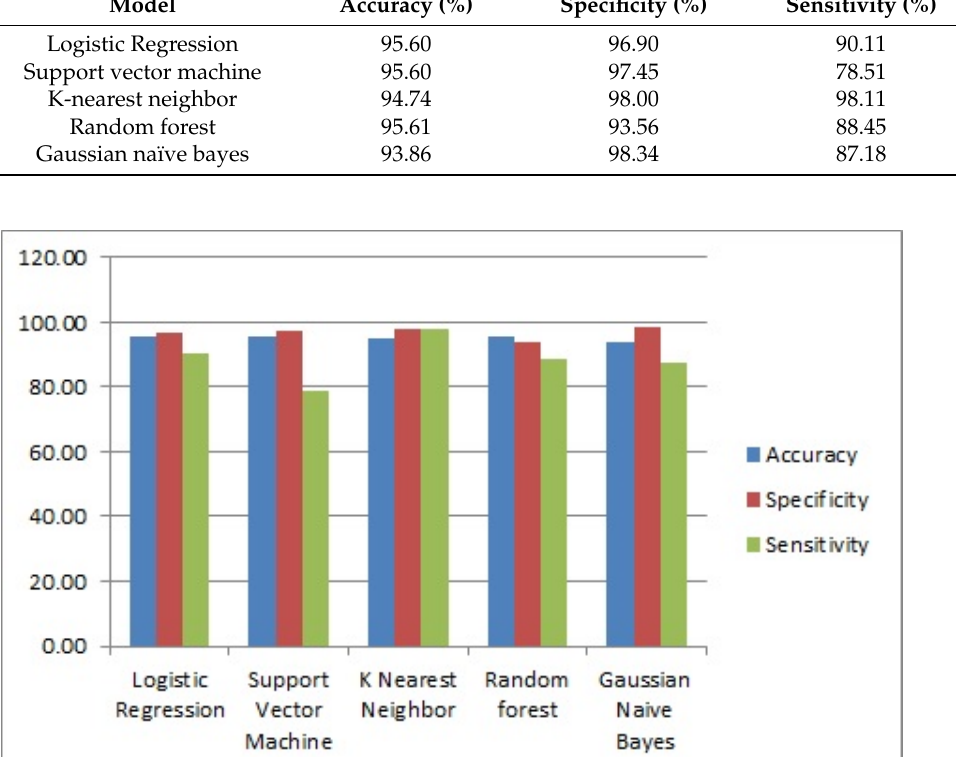
Figure 8. Chart presentation of performance evaluation result of classification models with selected fittest features.